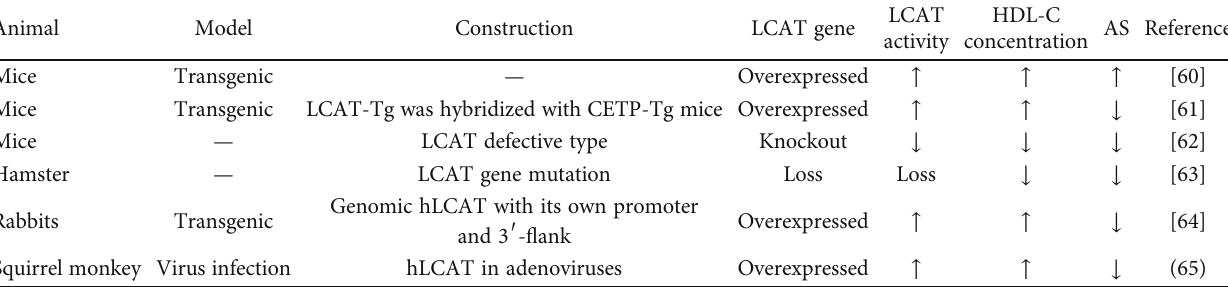
Table 1: Animal models exploring the role of the LCAT gene in cholesterol metabolism.